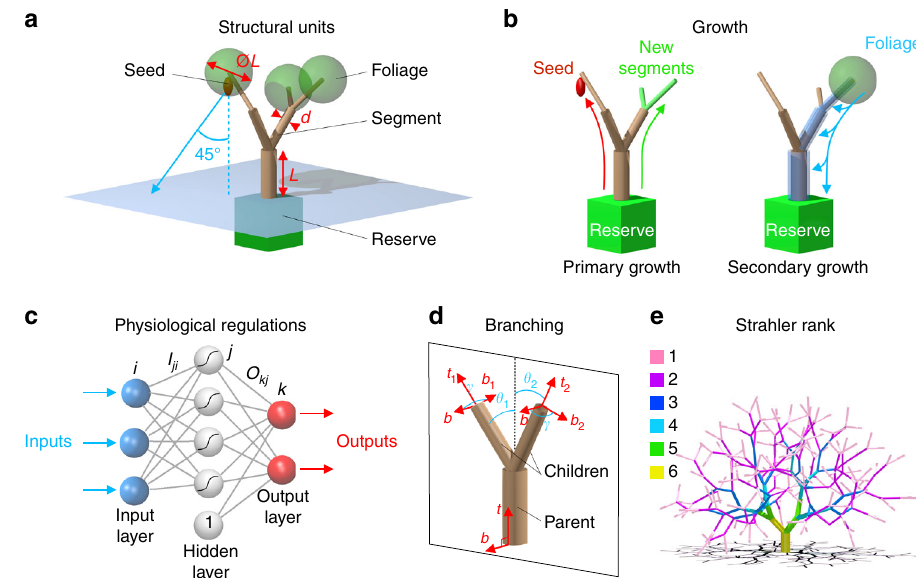
Fig. 1 Principles of MECHATREE. a Each virtual tree is an assembly of different units: segments, foliages, seeds and a reserve. b Primary growth relies on the reserve to grow new segments and seeds. Secondary growth costs include maintenance in addition to diameter growth of each branch segment. c Formal neural networks are used to model the biochemical regulation of growth. d The growth of new segments follows a rule based on three angles: θ 1 , θ 2 and γ . e Illustration of Strahler ordering of branches (Methods